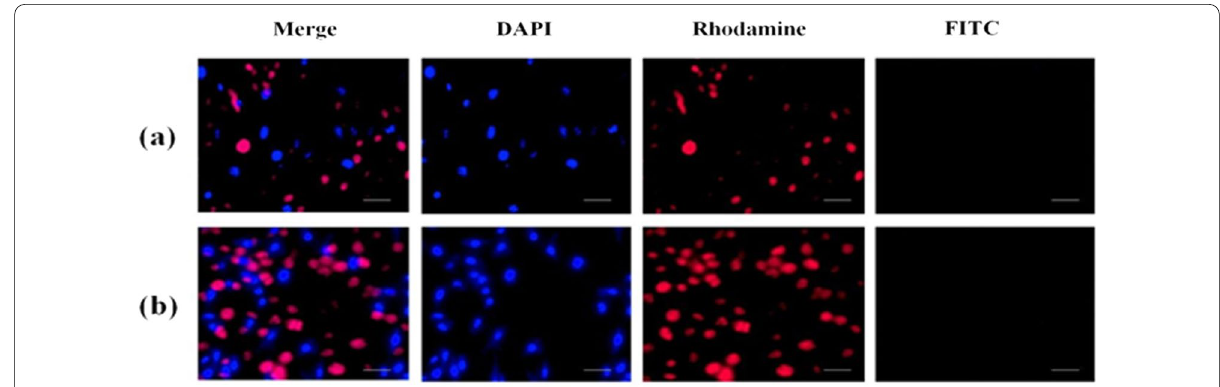
Fig. 11 Cellular uptake study (confocal microscopic images) of optimized formulation a 5 µg/ml concentration of gallic acid nanoparticles, b 20 µg/ml concentration of gallic acid nanoparticles